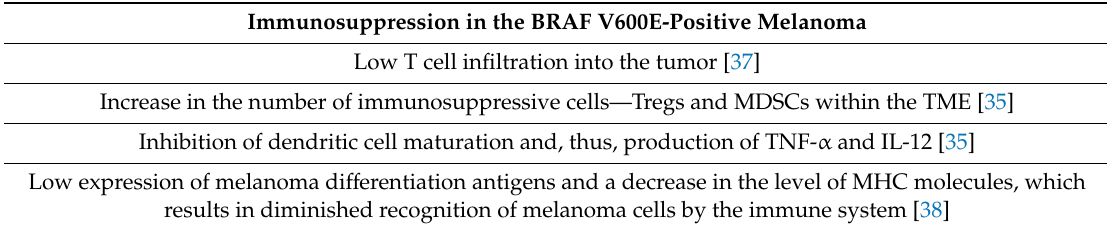
Table 3. Immunosuppressive mechanisms exhibited by BRAF V600E-mutated melanoma. Immunosuppression in the BRAF V600E-Positive Melanoma Low T cell infiltration into the tumor [37] Increase in the number of immunosuppressive cells—Tregs and MDSCs within the TME [35] Inhibition of dendritic cell maturation and, thus, production of TNF- α and IL-12 [35] Low expression of melanoma di ff erentiation antigens and a decrease in the level of MHC molecules, which results in diminished recognition of melanoma cells by the immune system